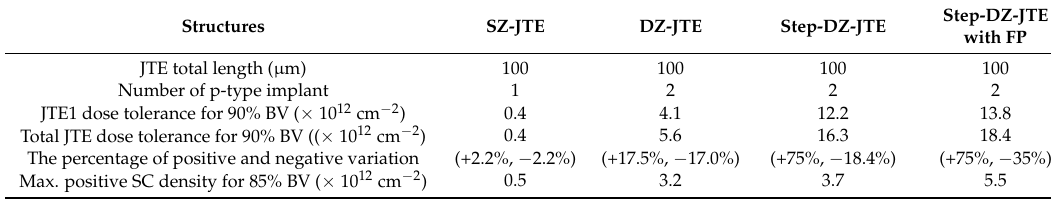
Table 2. Basic properties of different